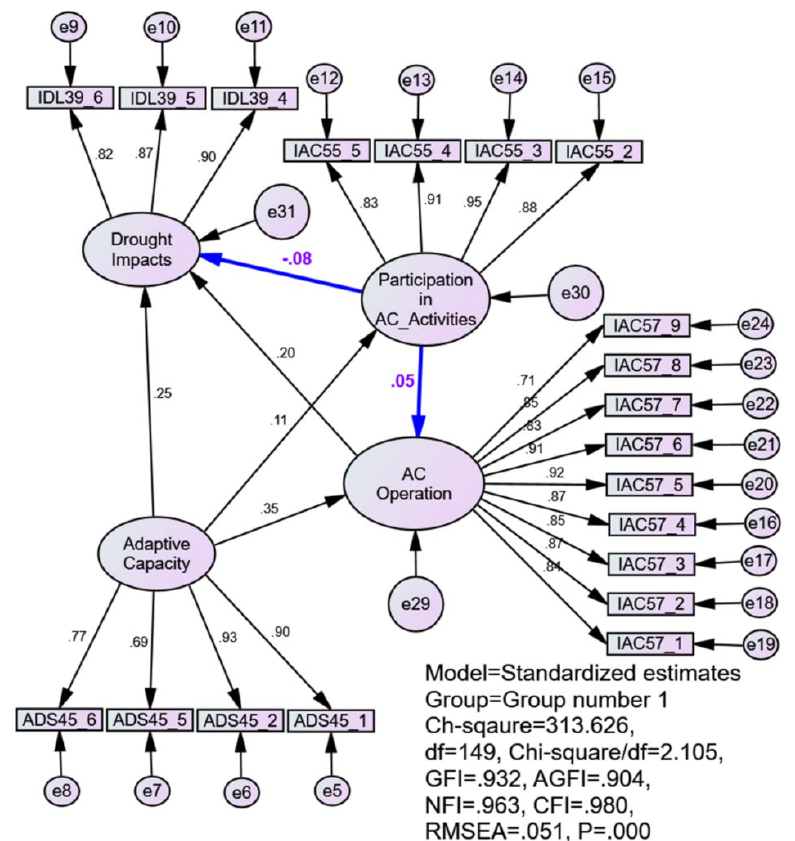
Figure 5. The results of the structural equation modeling (SEM).